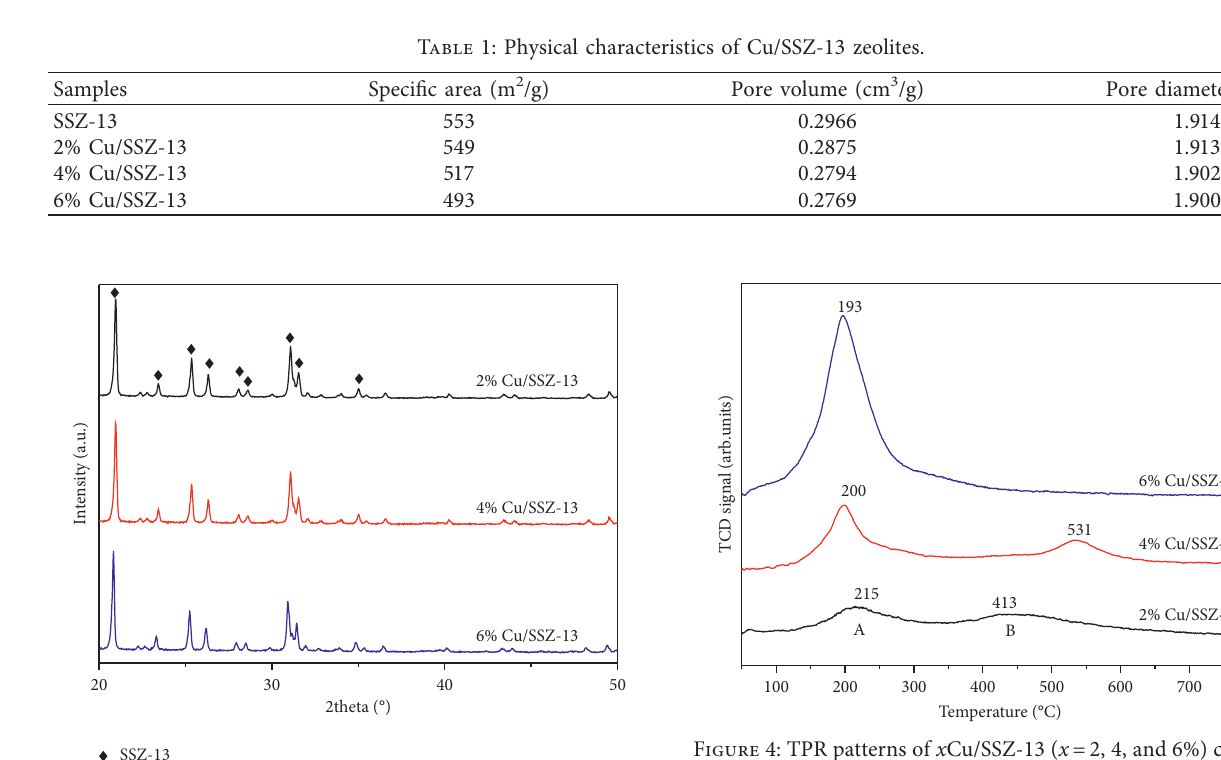
Figure 2: XRD patterns of the x Cu/SSZ-13 ( x � 2, 4, 6%) catalysts.